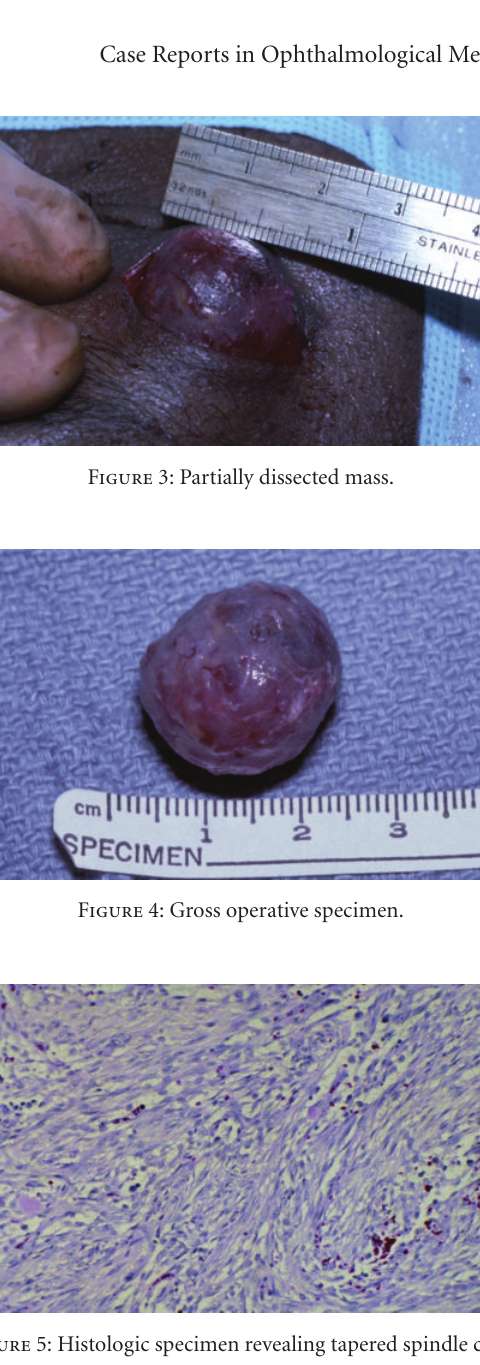
Figure 5: Histologic specimen revealing tapered spindle cells.